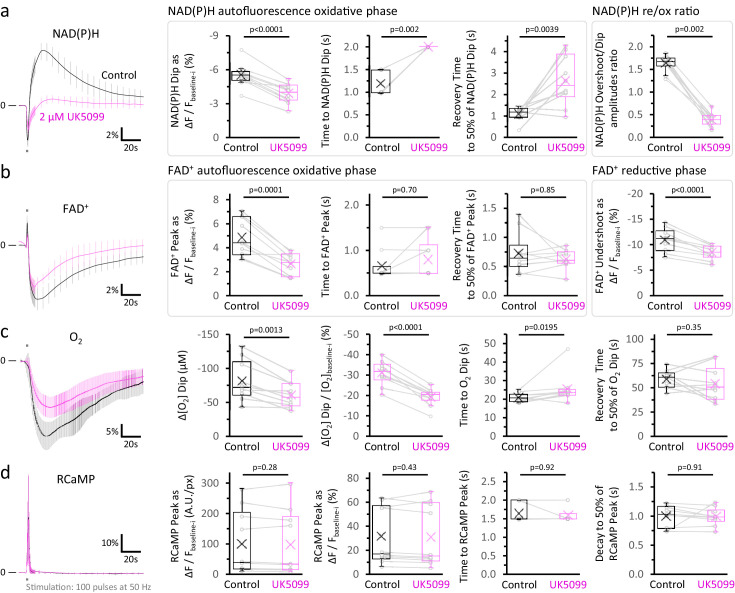
After MPC inhibition, O2 consumption and FADH2 production are less affected than mitochondrial NADH production in acutely stimulated DGCs.(a) The traces represent the average normalized NAD(P)H signals (mean ± SD) before and after 2 µM UK5099 (as in Figure 2b), elicited by antidromic stimulation. The baseline before each stimulation (Fbaseline-i) was subtracted from the raw trace. The difference between the baseline and the dip (ΔF=Fdip-Fbaseline-i), presented as percent change over the baseline (ΔF/Fbaseline-i), was compared between the two conditions. Other panels show the comparisons for the time from the beginning of the stimulation to the minimum value of the initial dip and the recovery time from that minimum value to 50% of the amplitude of the dip. Additionally, we compared the overshoot/dip ratio, which reflects the relative contributions of the reductive and the oxidative phases to the NAD(P)H signal (re/ox), independently of changes in the baseline autofluorescence (Ivanov et al., 2014). This comparison also shows a decreased mitochondrial NADH production in stimulated neurons, following MPC inhibition. (b) Average normalized FAD+ traces, expressed as percent change from the baseline before each stimulation (Fbaseline-i). The difference between the baseline and the initial peak, or the undershoot (ΔF=Fpeak or undershoot-Fbaseline-i), were calculated as a percent change over the baseline (ΔF/Fbaseline-i). The time from the beginning of the stimulation to the peak, and the recovery time from the peak to 50% of its amplitude, were also compared. (c) Average normalized O2 recordings, expressed as percent change from the baseline before each stimulation. The graphs show the difference between the baseline and the dip in the O2 signal elicited by stimulation (Δ[O2]=[O2]dip-[O2]baseline-i), either as the absolute change (expressed in µM) or as percent change over the baseline (Δ[O2]/[O2]baseline-i). The time from the beginning of the stimulation to the minimum value of the [O2] upon stimulation, and the recovery time from this value to 50% of its amplitude, were also compared. (d) Average normalized RCaMP traces, expressed as percent change from the baseline before each stimulation (Fbaseline-i). The difference between the intensities at baseline and at the peak (ΔF=Fpeak-Fbaseline-i), expressed as A.U./px or as the percent change over the baseline (ΔF/Fbaseline-i), were compared between the recordings before and after MPC inhibition. The time from the beginning of the stimulation to the peak, and the recovery time from the peak to 50% of its amplitude, were also compared. Surprisingly, neither the dip of the NAD(P)H signal nor the transient increase in O2 consumption in the tissue were as attenuated as the NAD(P)H overshoot, although both were mildly decreased. A likely explanation for these changes is that MPC inhibition partially depolarizes mitochondria, slowing down events that require an energized mitochondria. These events include Ca2+ influx, the adenine nucleotide exchanger and Complex V (Metelkin et al., 2006; reviewed by Kann and Kovács, 2007; Zorova et al., 2018), all of which further dissipate the mitochondrial membrane potential and/or the proton gradient, contributing to NADH oxidation. Data points obtained before and after the application of UK5099 are connected by lines (Nslices = 10 and Nmice = 6 for NAD(P)H and FAD+ autofluorescence signals, along with RCaMP fluorescence). Oxygen recordings were performed simultaneously to the autofluorescence signals in most of the experiments, except one (Nslices = 10 and Nmice = 5). A paired Student’s t test was used for comparisons between normally distributed data, or a non-parametric paired Wilcoxon test was used otherwise.